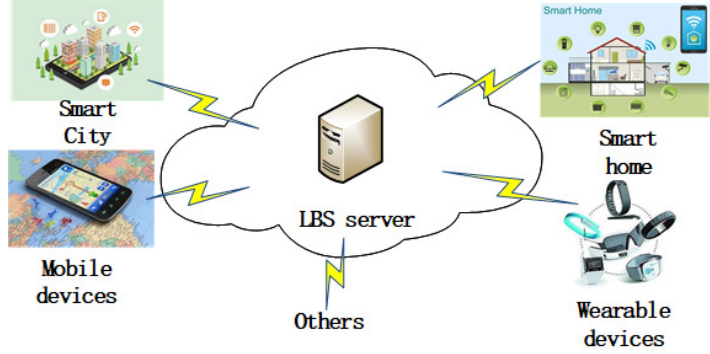
Figure 1. Location services and applications in the Internet of Things